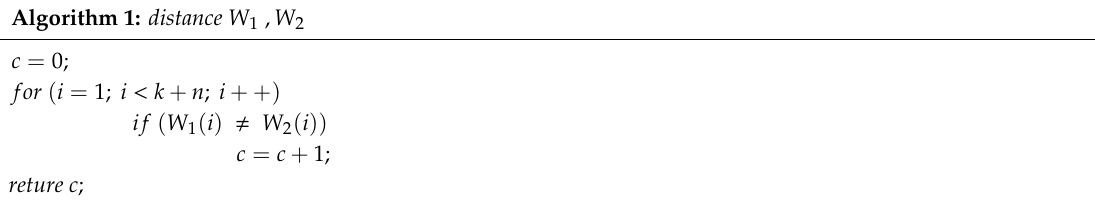
Algorithm 1: distance W 1 , W 2